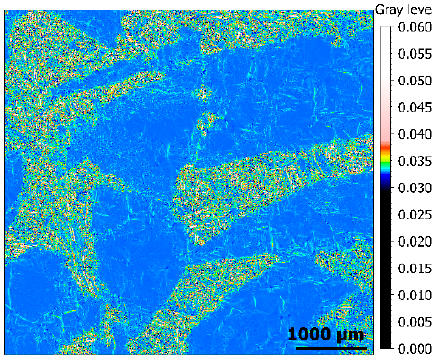
Figure 6. Rendering of a Mehlum curvature map of a measurement of surface from material 3.